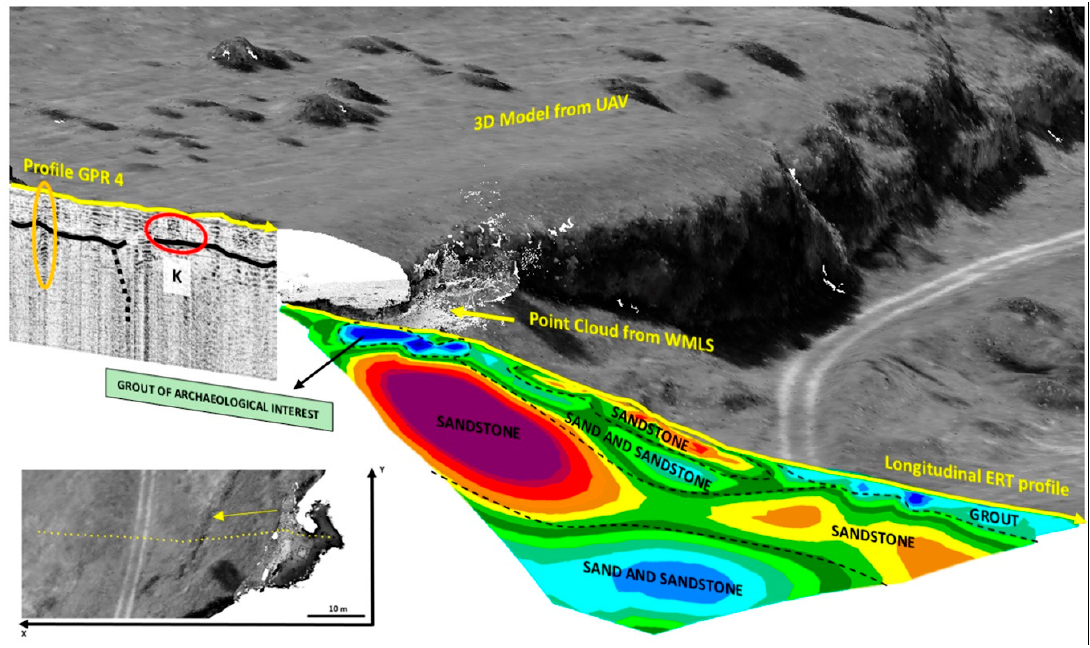
Figure14. Integratedmodelresultofthedataprovidedbythephotogrammetric, LiDARandgeophysical Figure 14. Integrated model result of the data provided by the photogrammetric, LiDAR and approaches geophysical approaches used.